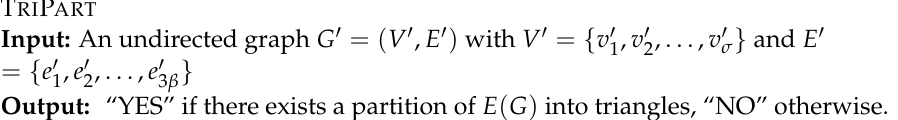
Figure 2. The subchain C i associated to node v (cid:48)